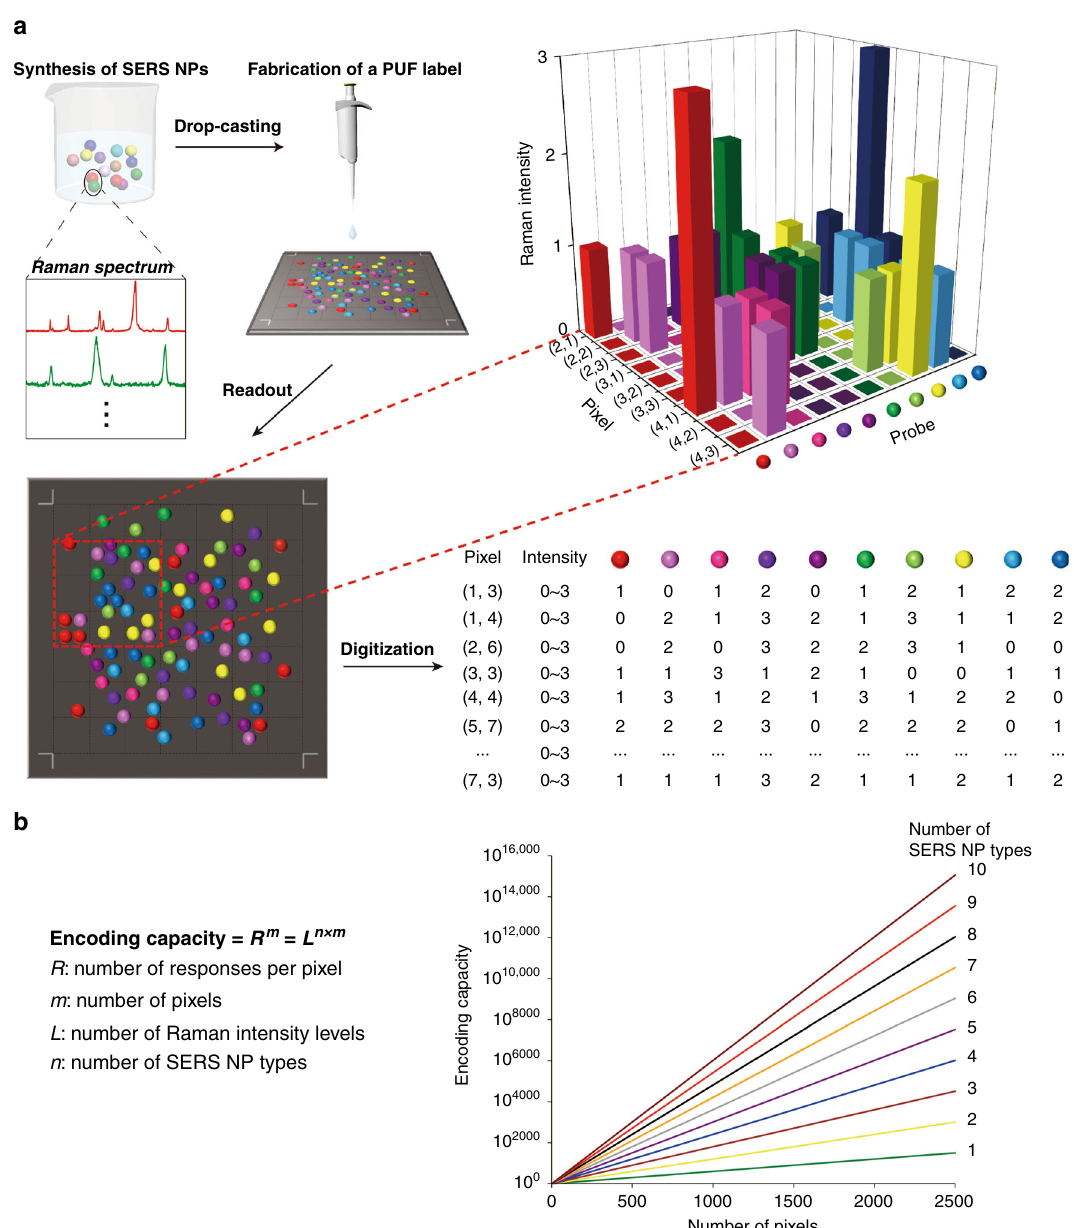
Fig. 1 Fabrication and encoding of Raman PUF labels. a A Raman signal-based physical unclonable function (PUF) label can be fabricated in four steps. First, surface-enhanced Raman scattering (SERS) nanoparticles (NPs) functionalized with ten different Raman reporter molecules are synthesized by a wet chemistry method. Each type of SERS NPs emits a unique vibrational Raman spectrum. Second, SERS NPs are deposited on a substrate and stochastically form a two-dimensional (2D) pattern after drying. The PUF label can then be read using a confocal Raman system by mapping and recording the signals at different points (e.g., 8 × 8 pixels in this example). The various SERS NPs at different locations on the substrate produce Raman spectra with speci fi c bands and intensities. A PUF label is fi nally produced by digitizing Raman mapping signals at each pixel in terms of the type of SERS NPs and the level of Raman intensities with the combination of the physical position of each pixel. b Calculation of the encoding capacity of a Raman PUF label. The formula (left) and the graph (right) show that the encoding capacity of a PUF label increases exponentially with the number of pixels ( m ) and as a power function of the number of possible responses for each pixel ( R ) in the recorded pattern. Furthermore, the number of responses of each pixel is a power function of the number of Raman intensity levels ( L ) and an exponential function of the type of SERS NPs ( n ). For example, if n = 10, L = 4, and m = 2500, the encoding capacity will be 4 10×2500 (3.2 × 10 15051 ). This fi gure composition refers to the ref. 7